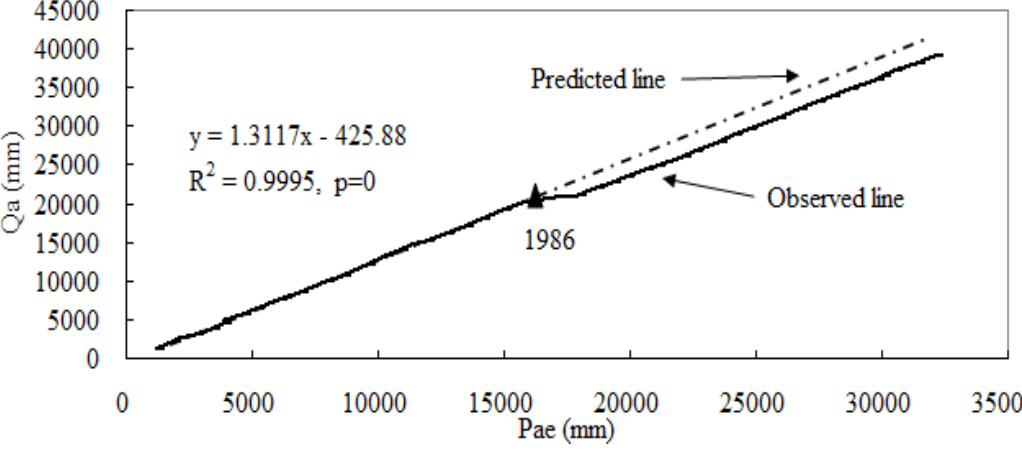
Figure 1. A hypothetical example of application of the MDMC (modified double mass curve) between cumulative annual runoff (Q ) for assessing the effects of forest change on annual mean flow. (P ae